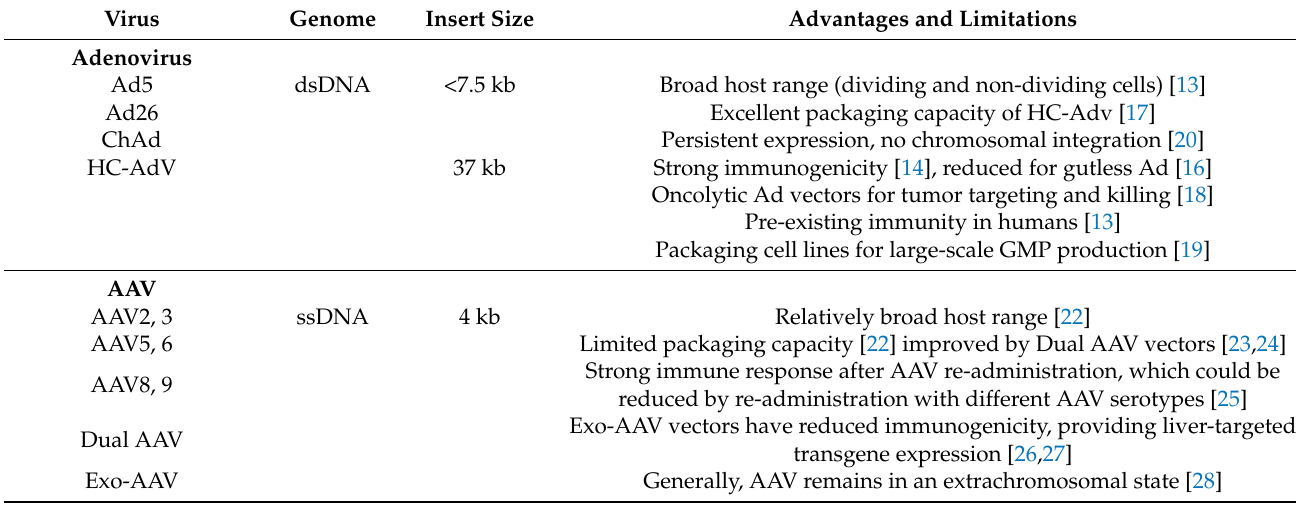
Table 1. Examples of viral vectors used for gene therapy